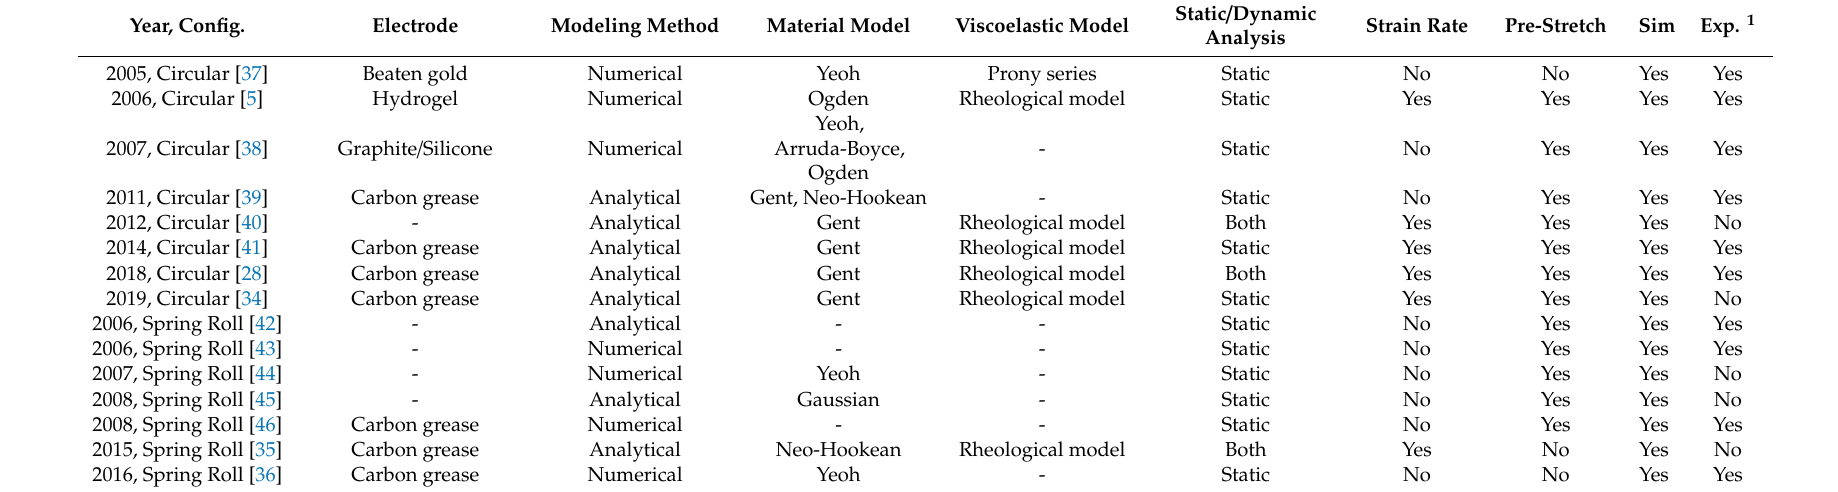
Table 2. Modeling trend of dielectric elastomer actuators